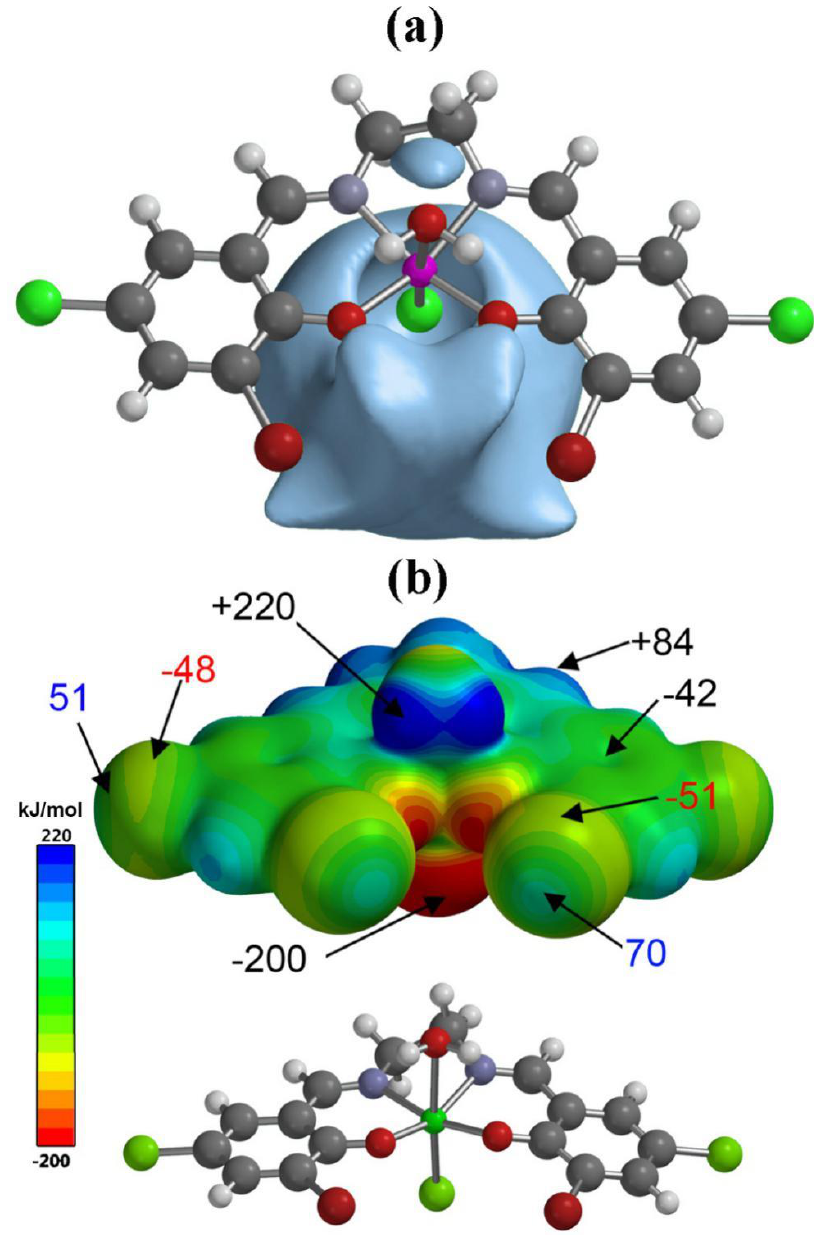
Figure 5. Molecular surface plot of the title compound: ( a ) electrostatic potential surface and ( b ) molecular electrostatic potential (MEP) surface of compound 1. The MEP values at selected points are given in kJ/mol −1 .